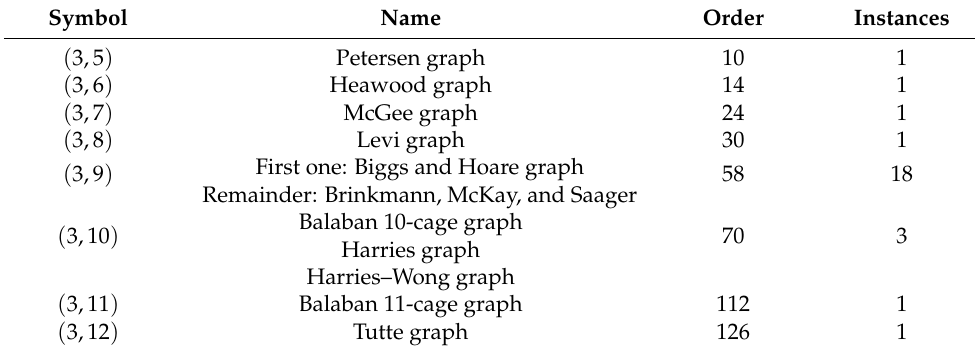
Table 3. ( 3, g ) -cage graph classification for g = { 5 · · · 12 } .